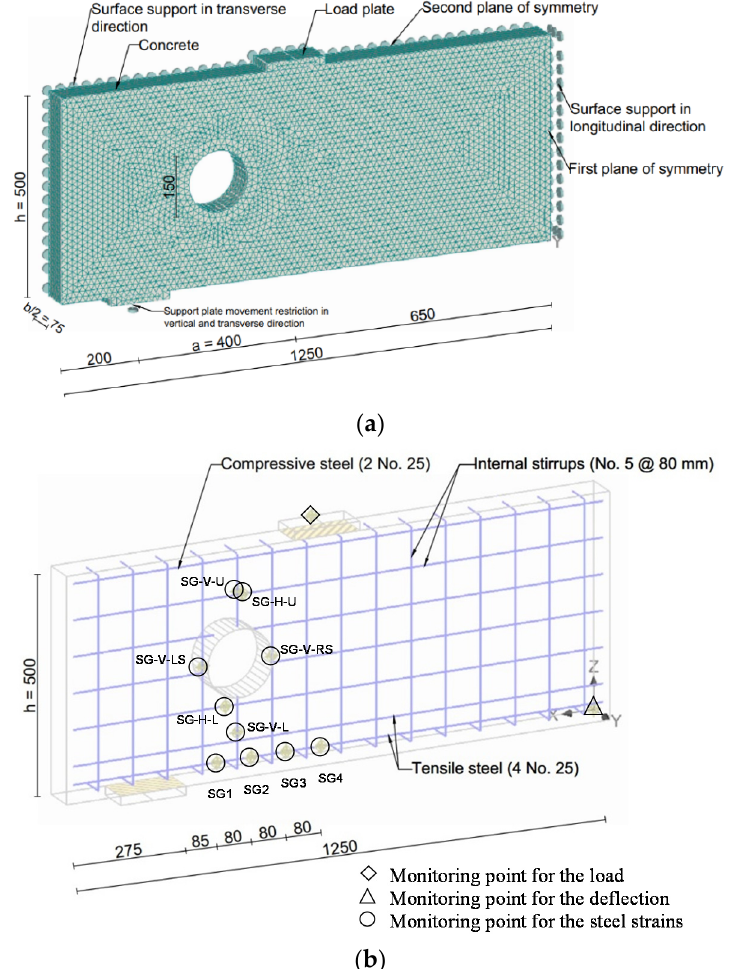
Figure 6. A typical deep beam model of group N (dimensions are in mm): ( a ) beam geometry configuration and boundary conditions; ( b ) reinforcement details and monitoring points.